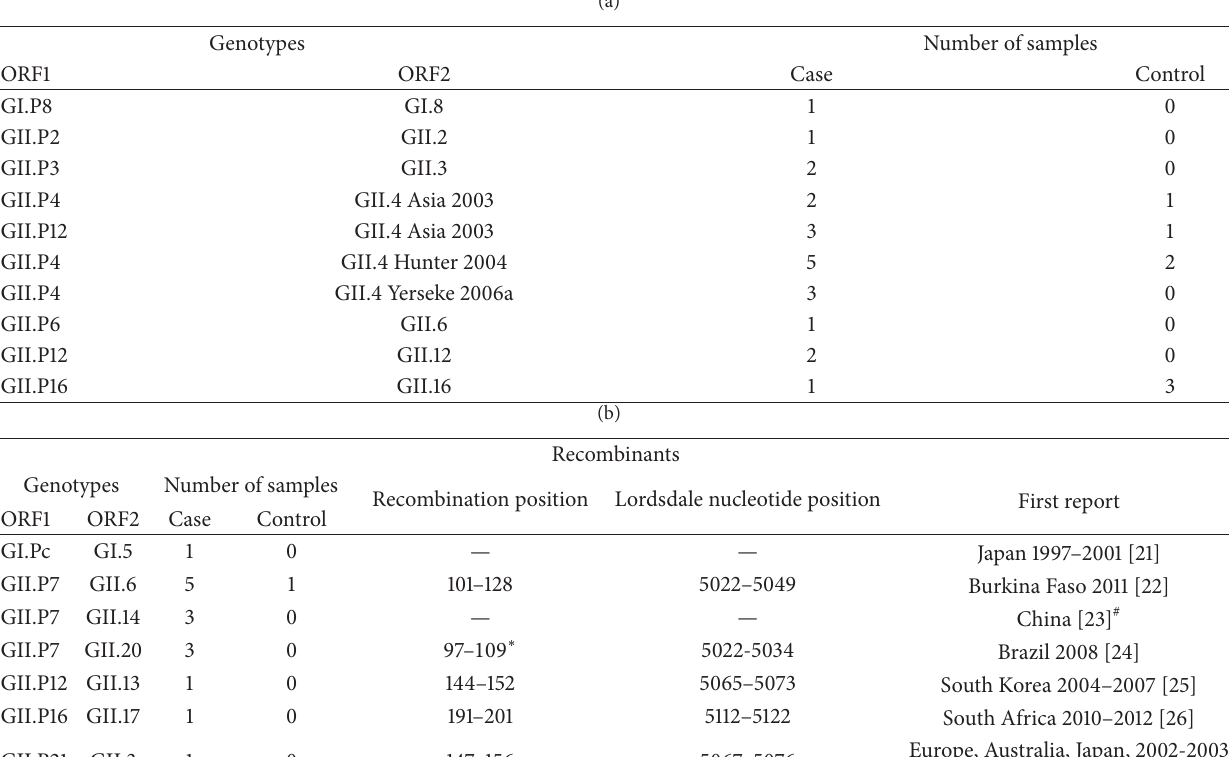
Table 2: Summary of nonrecombinant (a) and recombinant (b) norovirus genotypes detected in case and control samples based on the Norovirus Genotyping Tool and phylogenetic analysis and Simplot for recombination